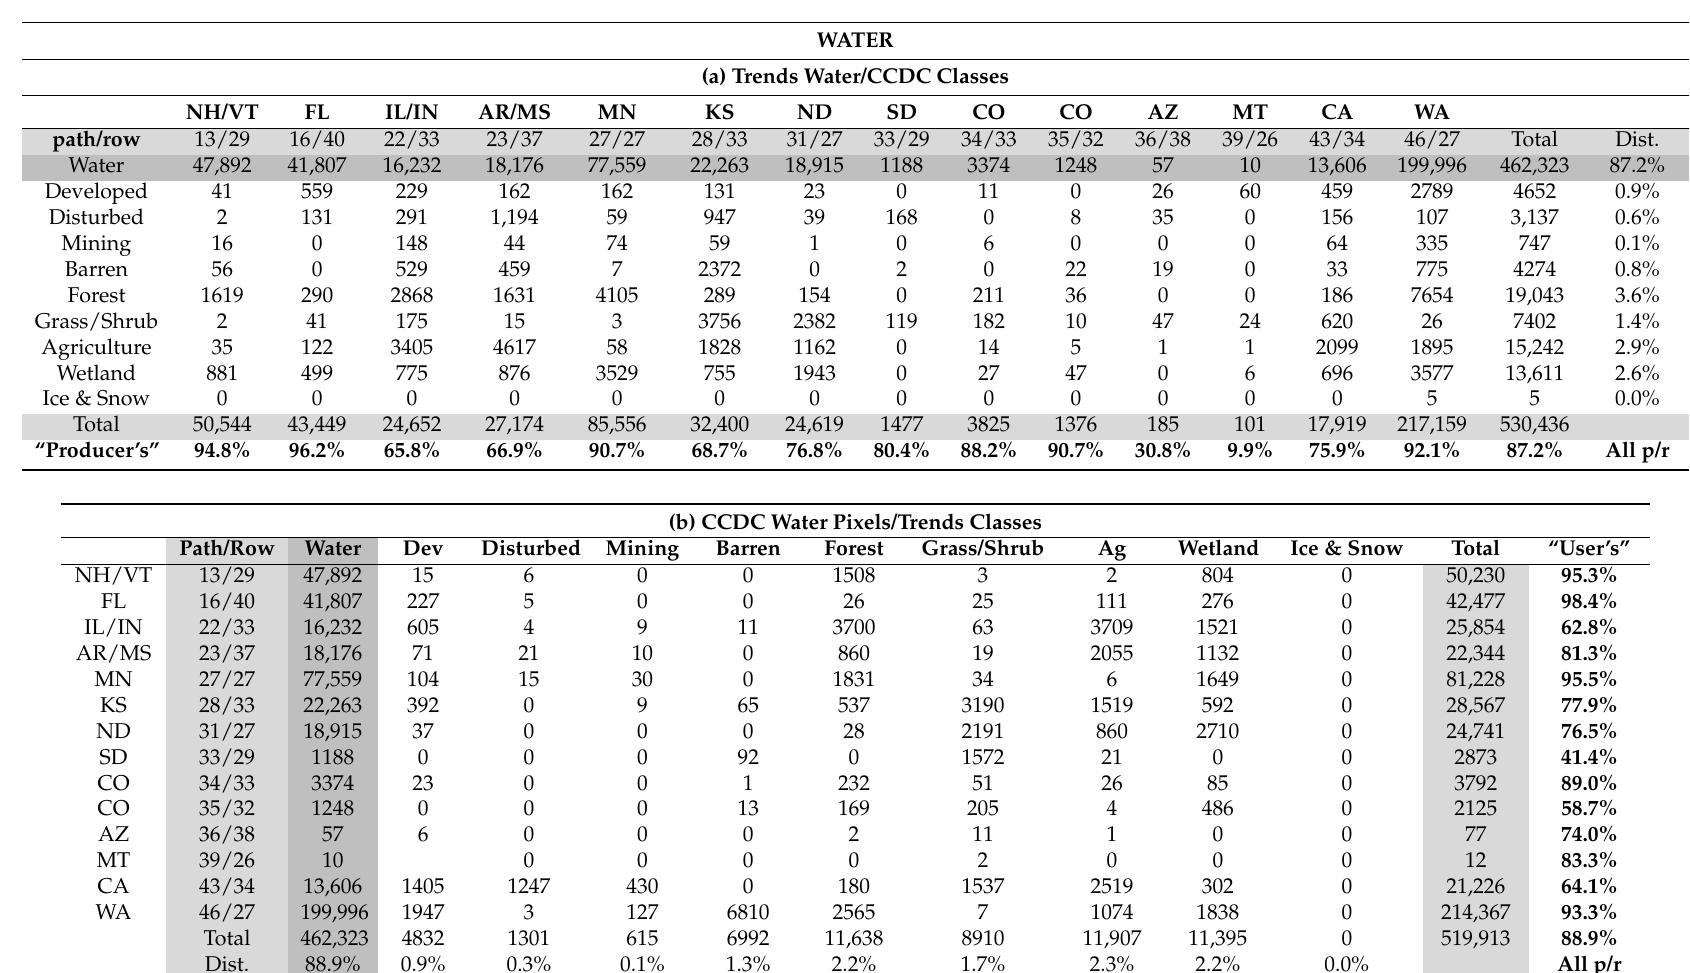
Table 10. (a) LC Trends Water pixels distributed across CCDC classes for each path/row location and (b) CCDC Water pixels distributed across LC Trends classes for each path/row. AR = Arkansas; AZ = Arizona; CA = California; CO = Colorado; FL = Florida; IL = Illinois; IN = Indiana; KS = Kansas; MN =